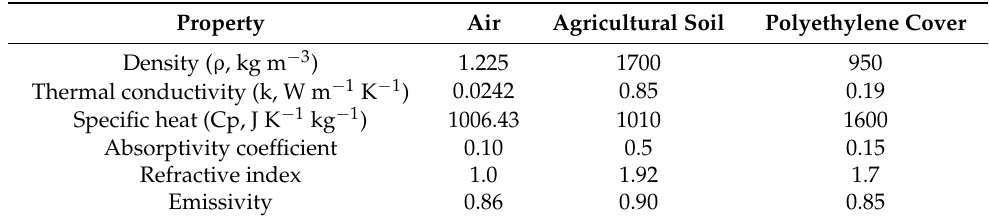
Table 1. Thermophysical and optical properties of the materials used in the simulation model. Adapted from Li et al. [35]. Property Air Agricultural